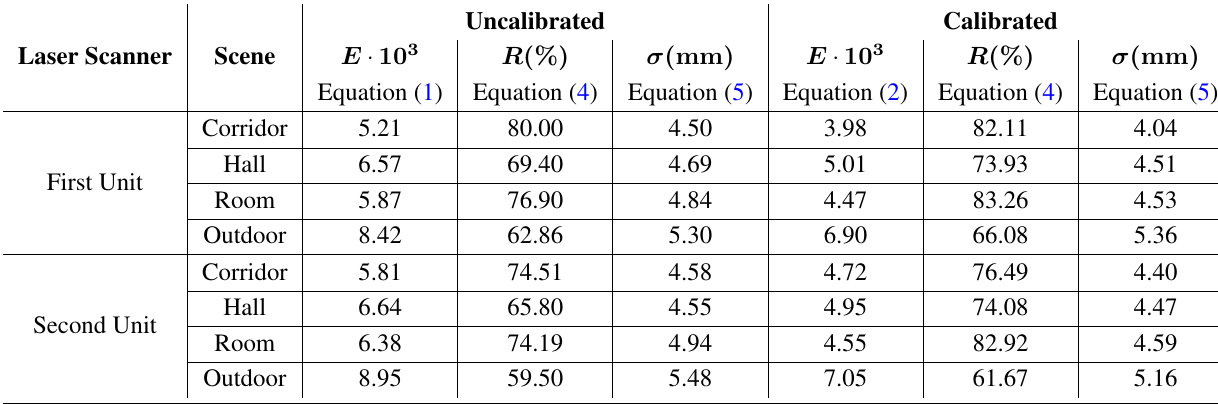
Table 3. Verification